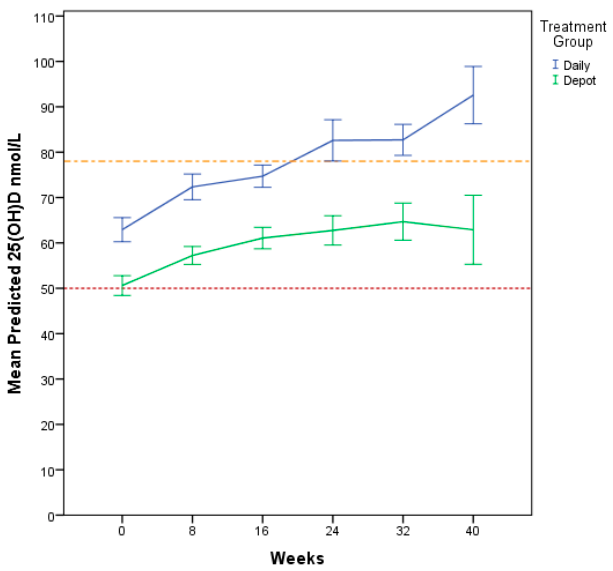
Table 4. Generalized Linear Mixed Models (GLMM) Model 1 Parameter Estimates for Vitamin D serum levels (25(OH)D nmol/L).